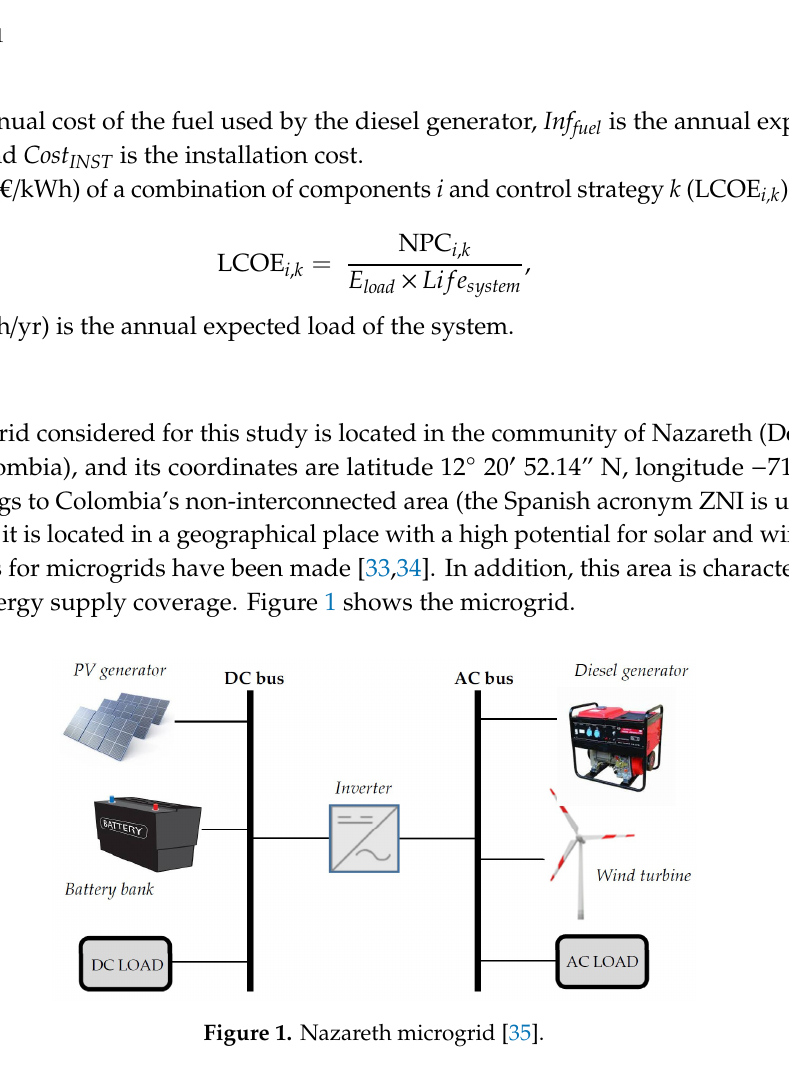
Table 1. Irradiation and wind speed at the microgrid location.